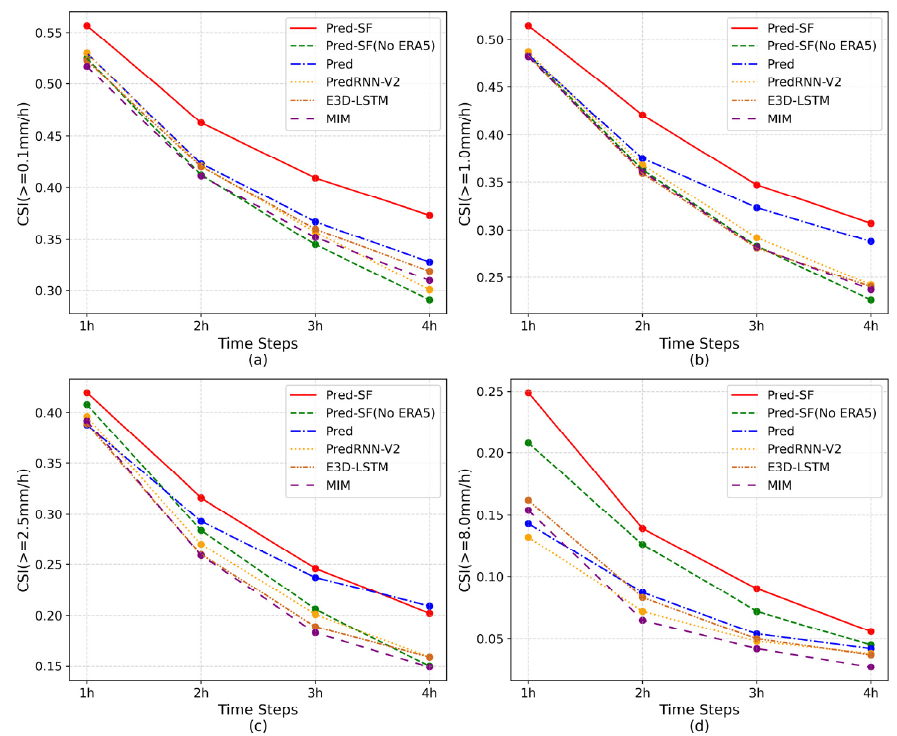
Figure 4. CSI index of the six groups of models at each prediction moment: ( a ) precipitation is greater than 0.1 mm/h; ( b ) precipitation is greater than 1.0 mm/h; ( c ) precipitation is greater than 2.5 mm/h; ( d ) precipitation is greater than 8.0 mm/h.